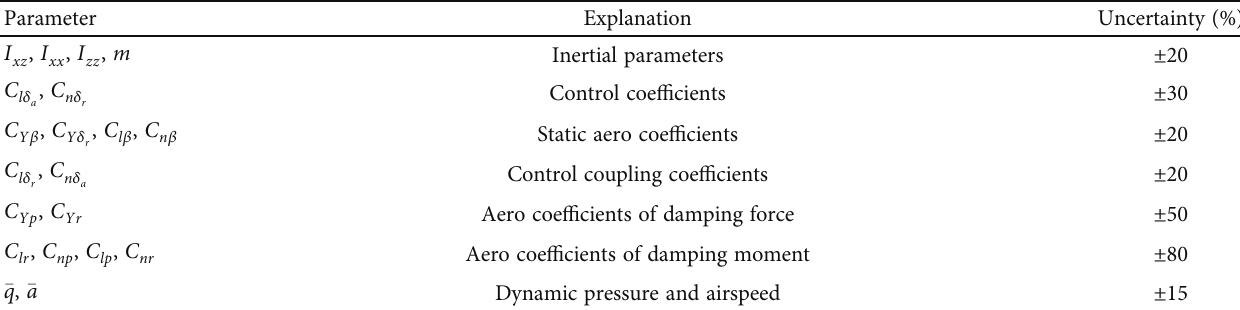
Table 8: Parameter uncertainties in the nonlinear